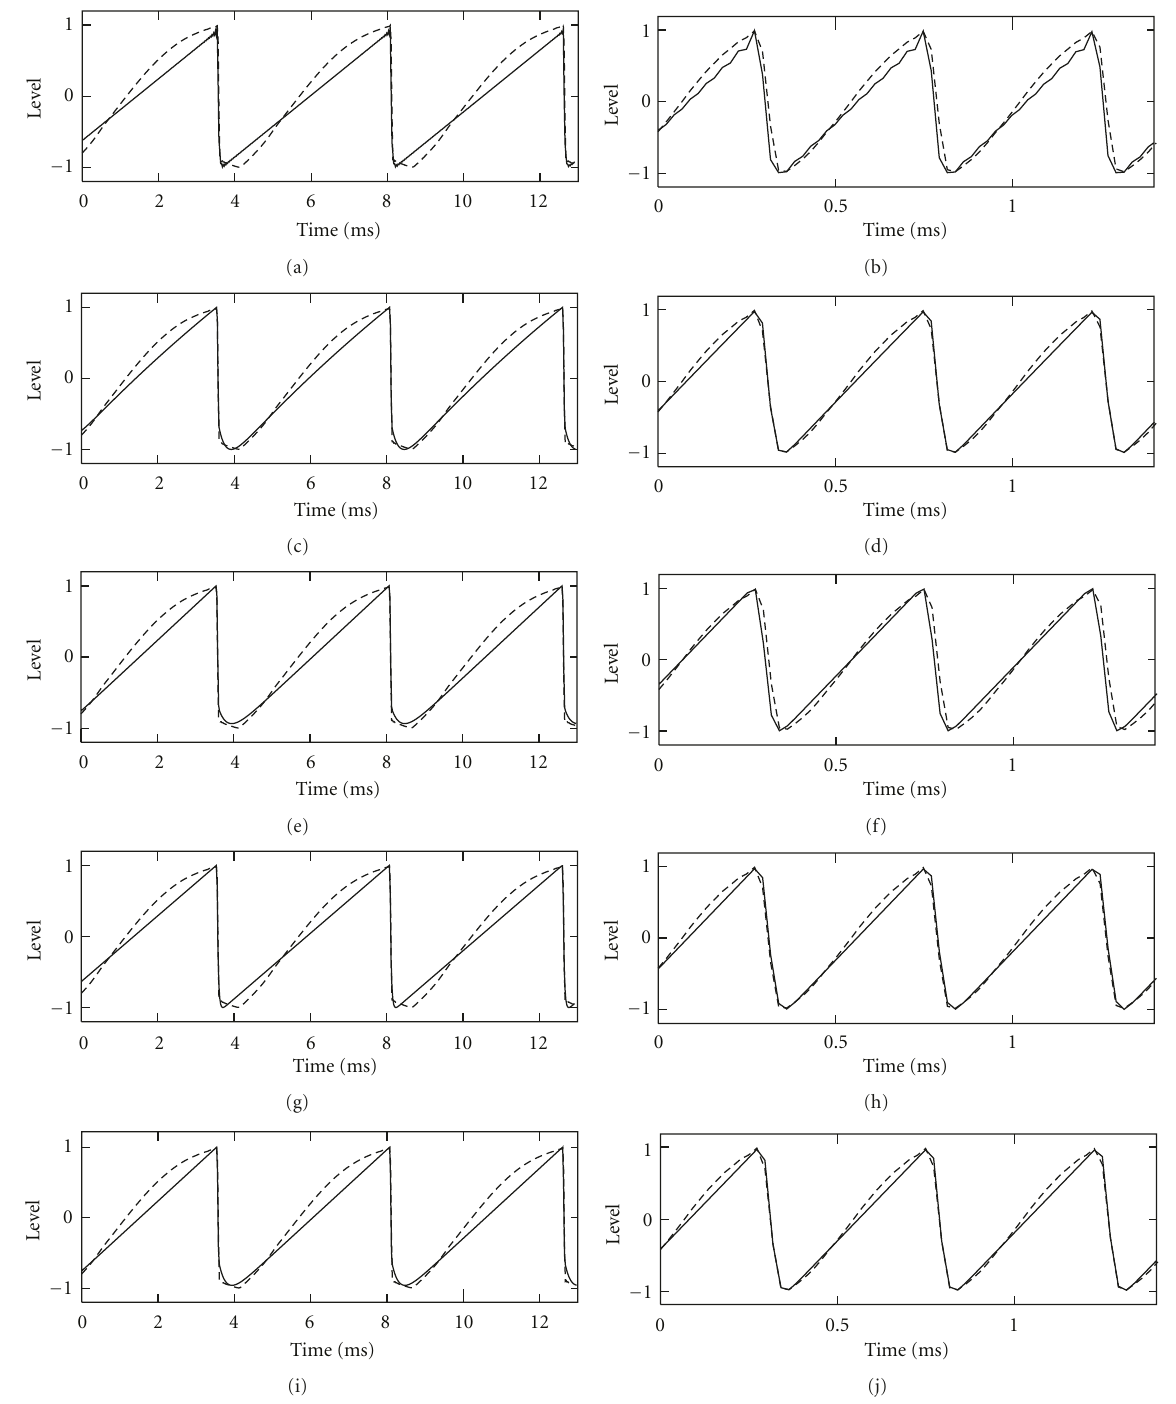
Figure 11: Waveforms of the filtered (a), (b) ideally bandlimited, (c), (d) third-order B-spline BLIT, (e), (f) third-order B-spline BLEP, (g), (h) second-order DPW, and (i), (j) fourth-order DPW sawtooth oscillator output at fundamental frequencies of 220.62Hz and 2.096kHz, respectively. The corresponding waveforms of the recorded signals are drawn with dashed line in all plots. fact, their maximum absolute harmonic magnitude error is oscillators. Although these approaches have worse RMSE below 3 dB at all tested fundamental than the phase distortion model (dash-dotted line in Fig- ures 12(c) and 12(e)), their maximum absolute harmonic magnitude errors are smaller than those of the phase distor- tion model (dash-dotted line in Figures 12(d) and 12(f)). In